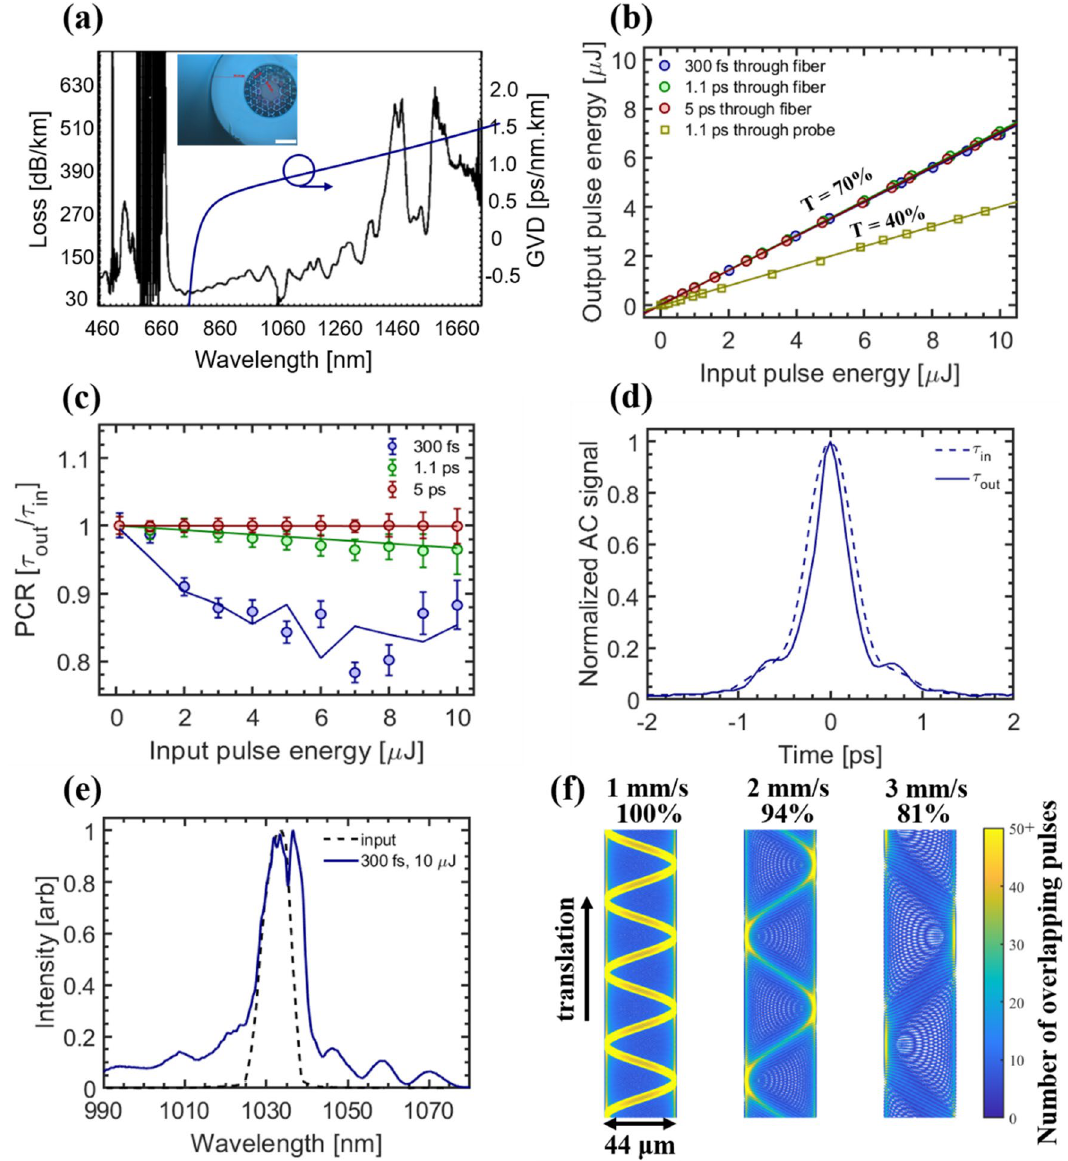
Figure 3. Kagome fiber characterization. ( a ) Measured loss and calculated disperion spectra of Kagome fiber. Inset shows en face view of fiber. Scale bar is 50 μm. ( b ) Measured transmission curves through 6 m long Kagome fiber for 300 fs, 1.1 ps, and 5 ps pulses and for the entire surgery probe at 1.1 ps. ( c ) Pulse compression ratio (PCR) at fiber output of 300 fs (blue), 1.1 ps (green), and 5 ps (red) pulses as a function of input pulse energy. Data points represent FHWM pulse widths measured with the autocorrelator (AC) while solid lines represent pulse widths predicted from simulations. Error bars represent 95% confidence intervals of sech 2 fits to autocorrelator pulse width measurements. ( d ) Autocorrelator trace of 300 fs pulse at fiber input (dotted line) and output (solid line) for an input pulse energy of 10 μJ. ( e ) Pulse spectrum of 300 fs pulse at fiber input (dotted line) and output (solid line) for an input pulse energy of 10 μJ. ( f ) Lissajous scanning simulations showing the effect of lateral translation speed on pulse deposition profile. Translational speed of 1 mm/s results in complete coverage while 2 mm/s and 3 mm/s provide 94% and 81% coverage, respectively. The color bar to the right indicates the number of overlapping pulses throughout the scan area. Laser repetition rate was 500 kHz for data collected in ( b – e